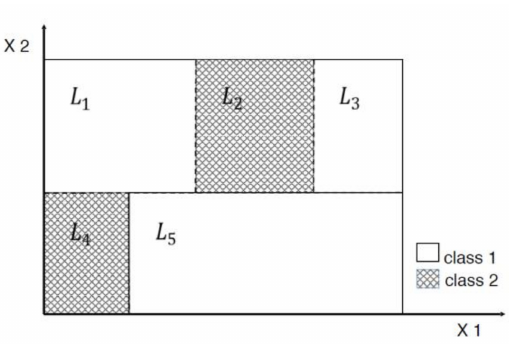
Figure 2. Distinct adjacent regions are { L 1 , L 2 } , { L 1 , L 4 } , { L 2 , L 3 } , { L 2 , L 5 } , and { L 4 , L 5 }